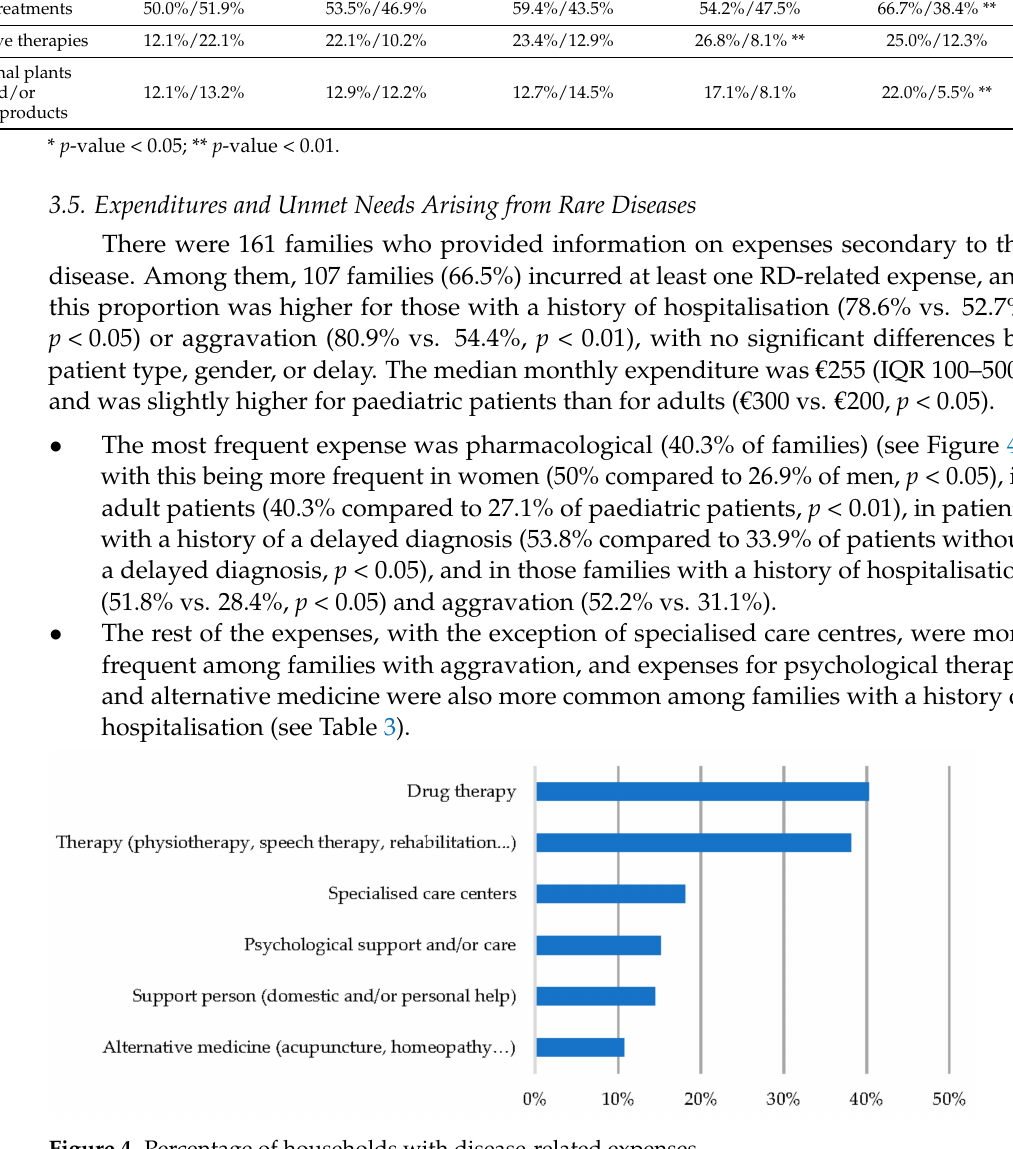
Figure 4. Percentage of households with disease-related